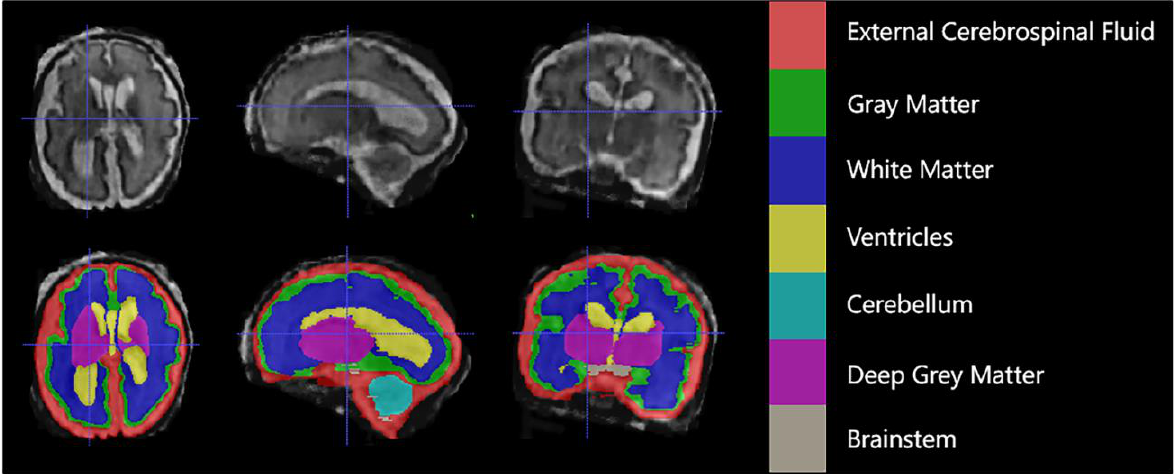
Figure 1. An example of manual segmentation (red: external cerebrospinal fluid; green: GM; dark blue: WM; yellow: ventricles; cyan: cerebellum; maroon: deep GM: gray: brainstem).